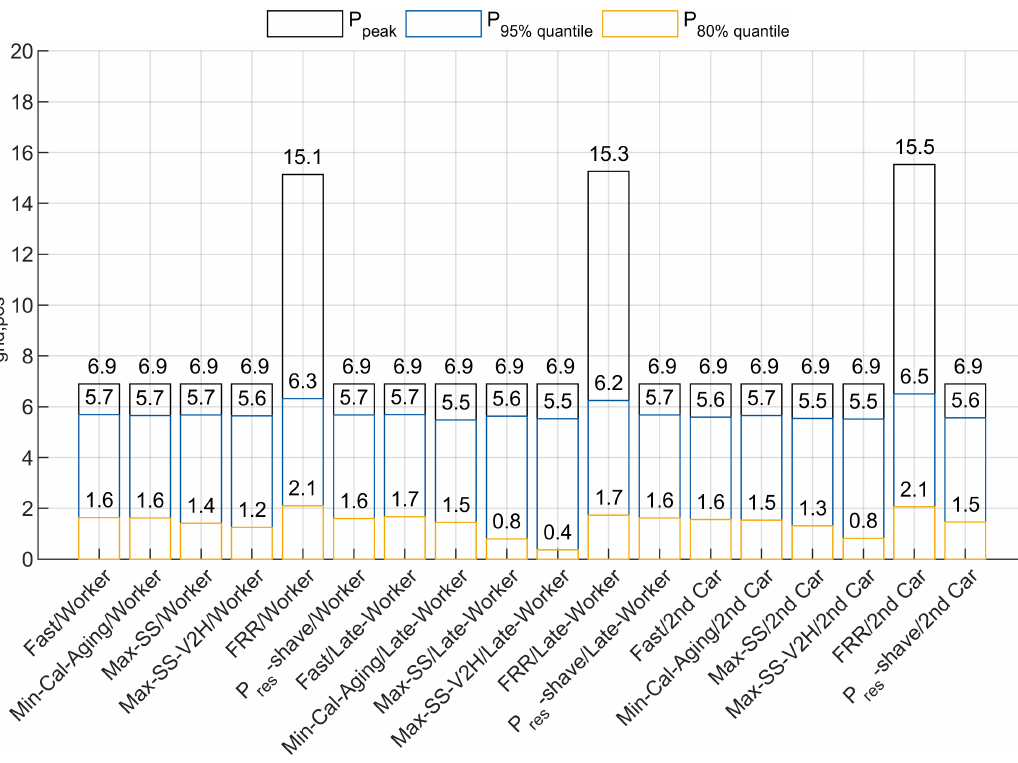
Figure A7. Positive power exchange of the household with the grid for workplace charging scenario W without SoC V 2 XLimit .